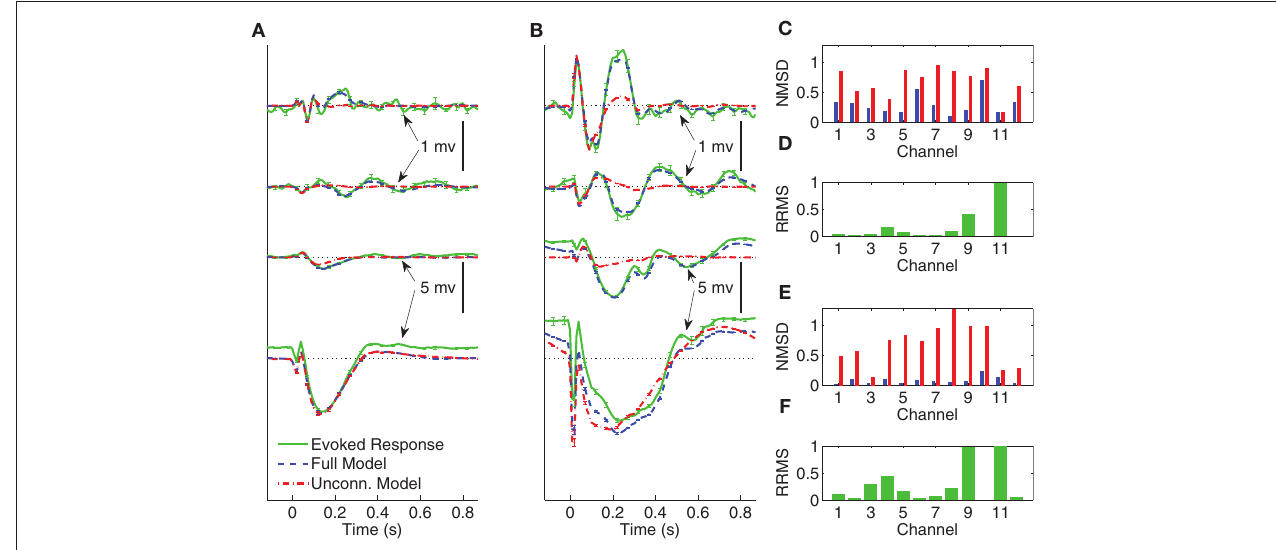
FIGURE 4 | Comparison between average CV evoked and average CV model responses of Subject A to two different stimulation strengths in wakefulness. In panels (A) and (B) the black dotted lines indicate the origin while the error bars denote the standard error of the mean. (A) Average CV evoked and average CV model responses of channels 1, 7, 4, and 11 with 1mA current stimulation. (B) Average CV evoked and average CV model